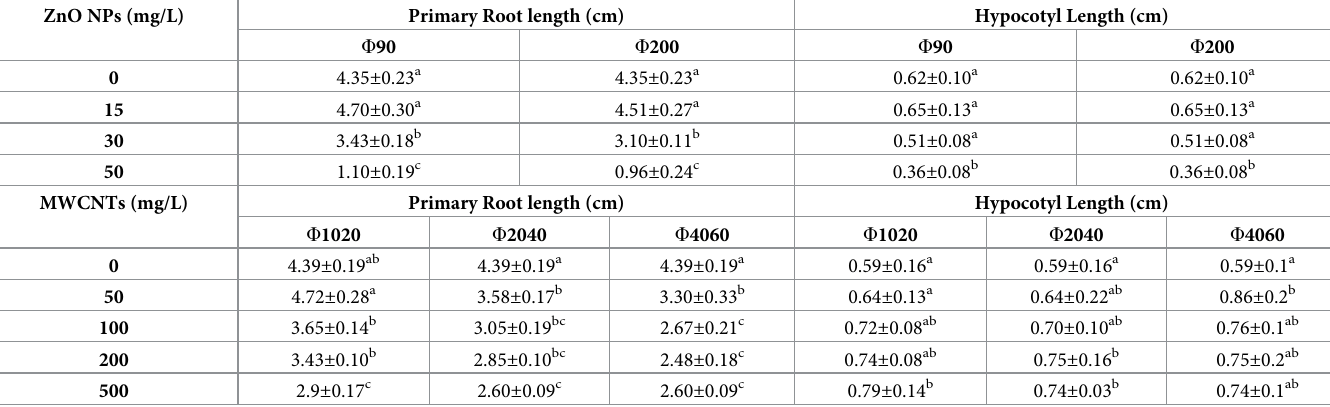
Table 1. Root length and hypocotyls of Arabidopsis seedlings at 10 DAG after treatment with ZnO NPs and MWCNTs, respectively. ZnO NPs